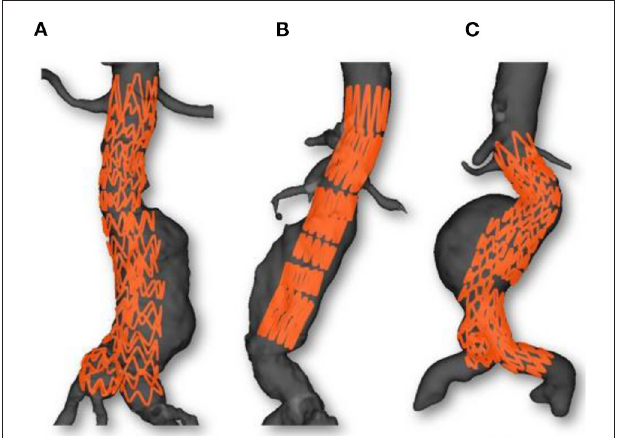
FIGURE 6 | Simulations results: Case 1 (A) , Case 2 (B) and Case 3 (C) . Simulated stent grafts are represented inside the patient aorta.